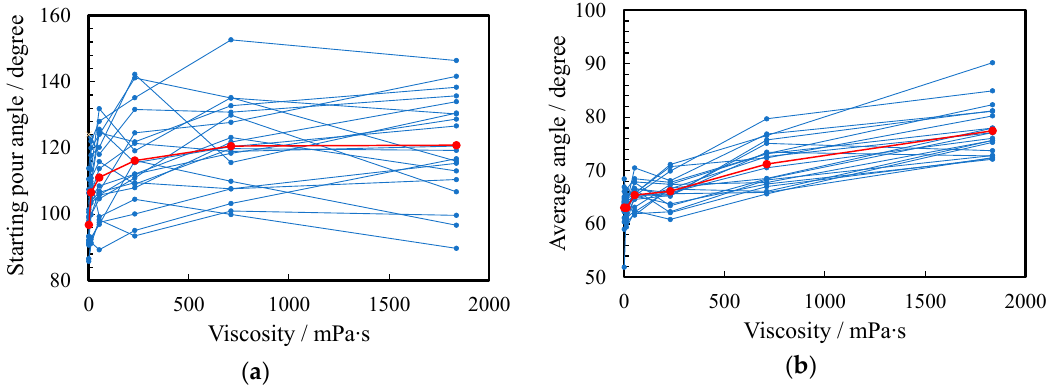
Figure 8. Relationship between angle and viscosity. ( a ) Starting pour angle and ( b ) average angle: water ( a ) and 1~5 wt% PEG500,000 aqueous solutions ( b – f ). The scores for all subjects and their arithmetic mean are plotted as small blue and large red circles, respectively.